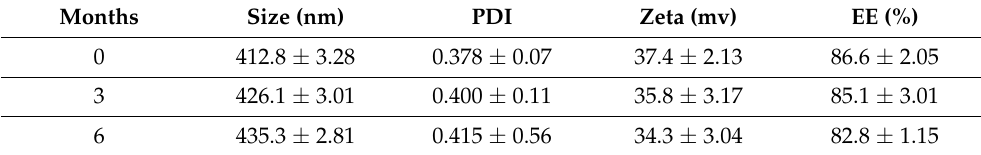
Table 3. Stability Study for LUT-CHS stored in refrigerator at 4 ◦ C within 6 months.